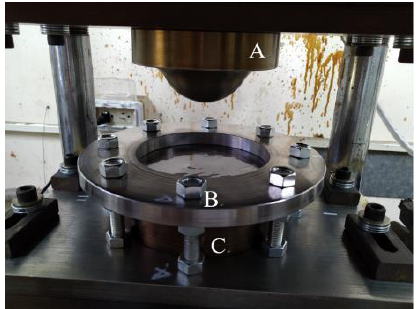
Figure 1. The punch (A), blank-holder (B), and die (C).